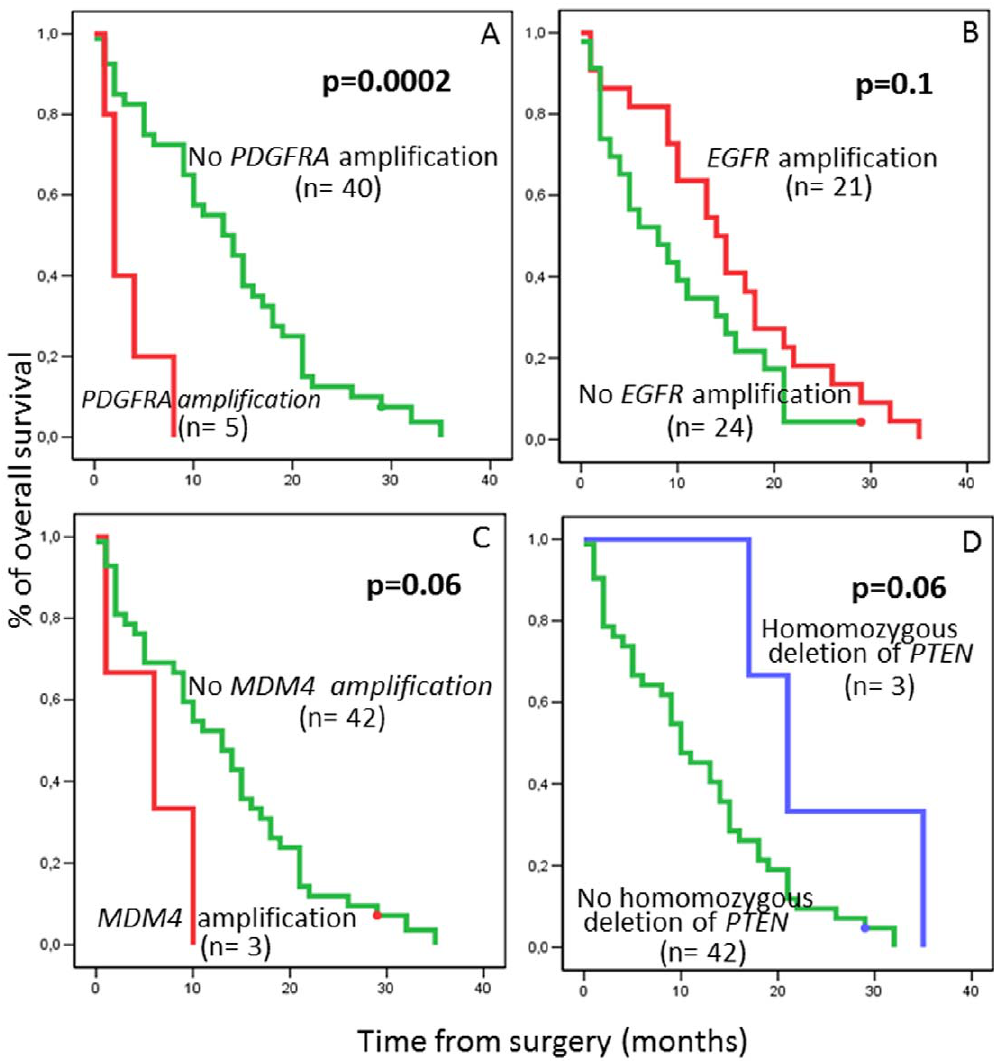
Figure 3. Overall survival curves of GBM patients (n=45) according to the presence vs absence of amplification of the PDGFRA (Panel A), EGFR (Panel B) and MDM4 genes (Panel C) and the presence vs absence of deletion of the PTEN gene (Panel